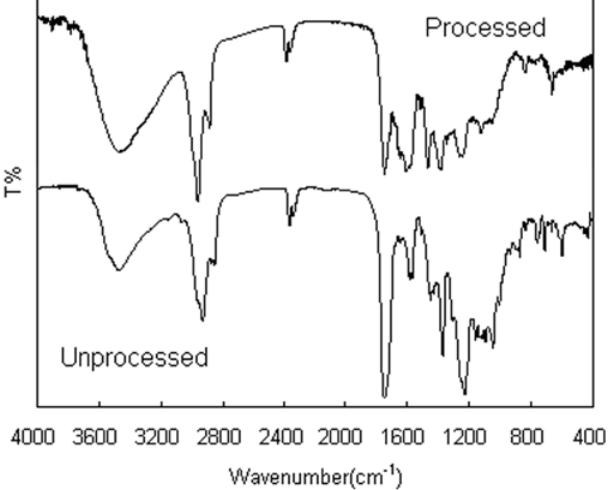
Figure 4. Comparative investigations on FTIR spectra of unprocessed and processed GTW.